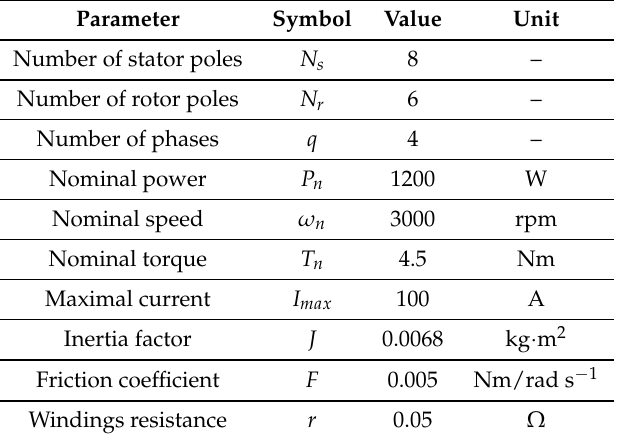
Table 1. Switched Reluctance Generator (SRG)